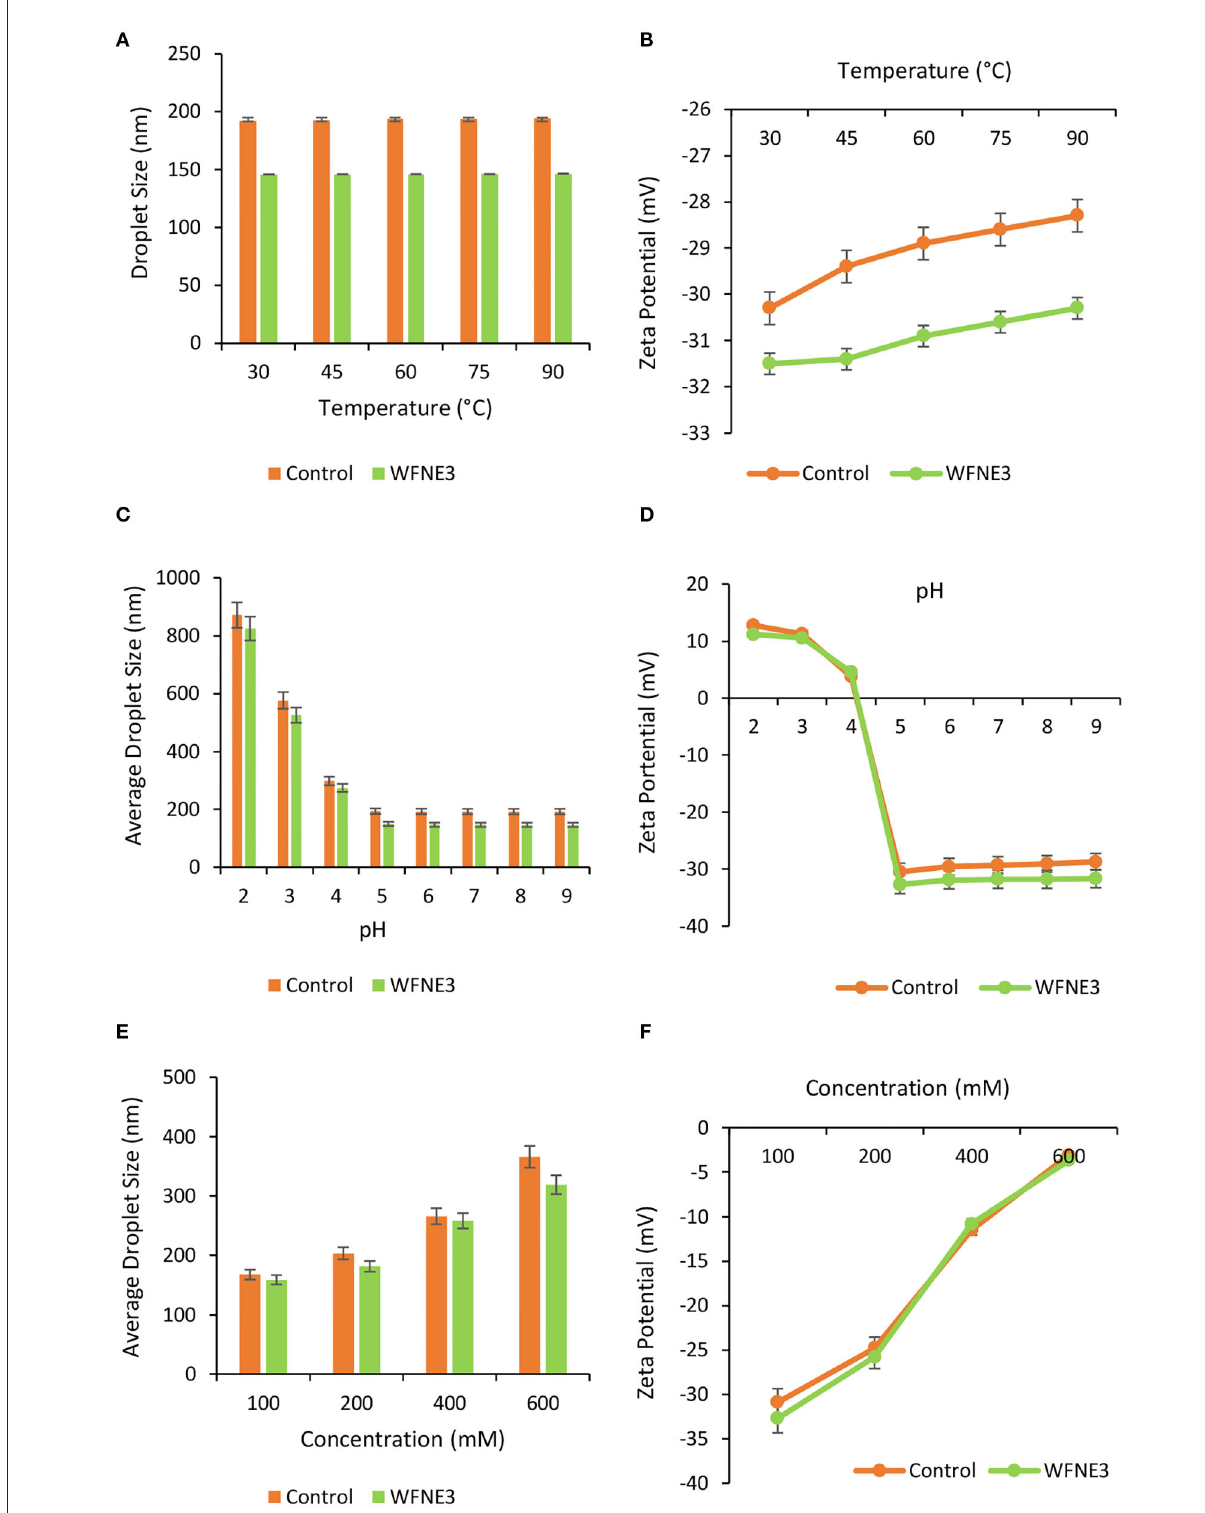
FIGURE3 Effect of different ranges of (A) temperature on droplet size of WFNE3 nanoemulsion; the (B) temperature on zeta potential of WFNE3 nanoemulsion; (C) pH on droplet size of WFNE3 nanoemulsion; (D) pH on zeta potential of WFNE3 nanoemulsion; (E) ionic concentration on droplet size of WFNE3 nanoemulsion; (F) ionic concentration on zeta potential of WFNE3 nanoemulsion. The error bar represents the standard deviation from the mean